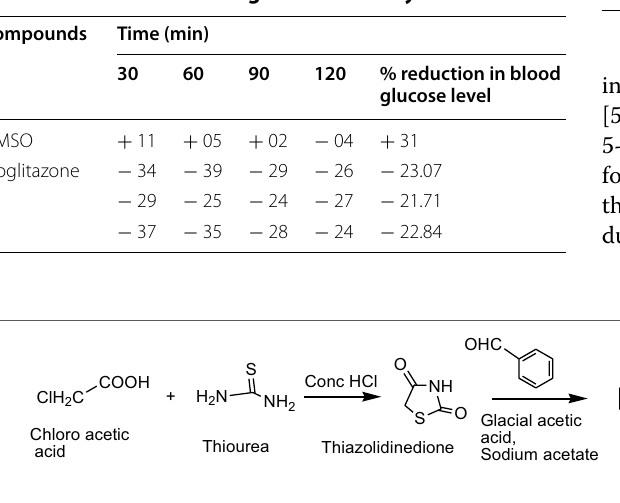
Table 2 Decrease in blood glucose levels by AUC method